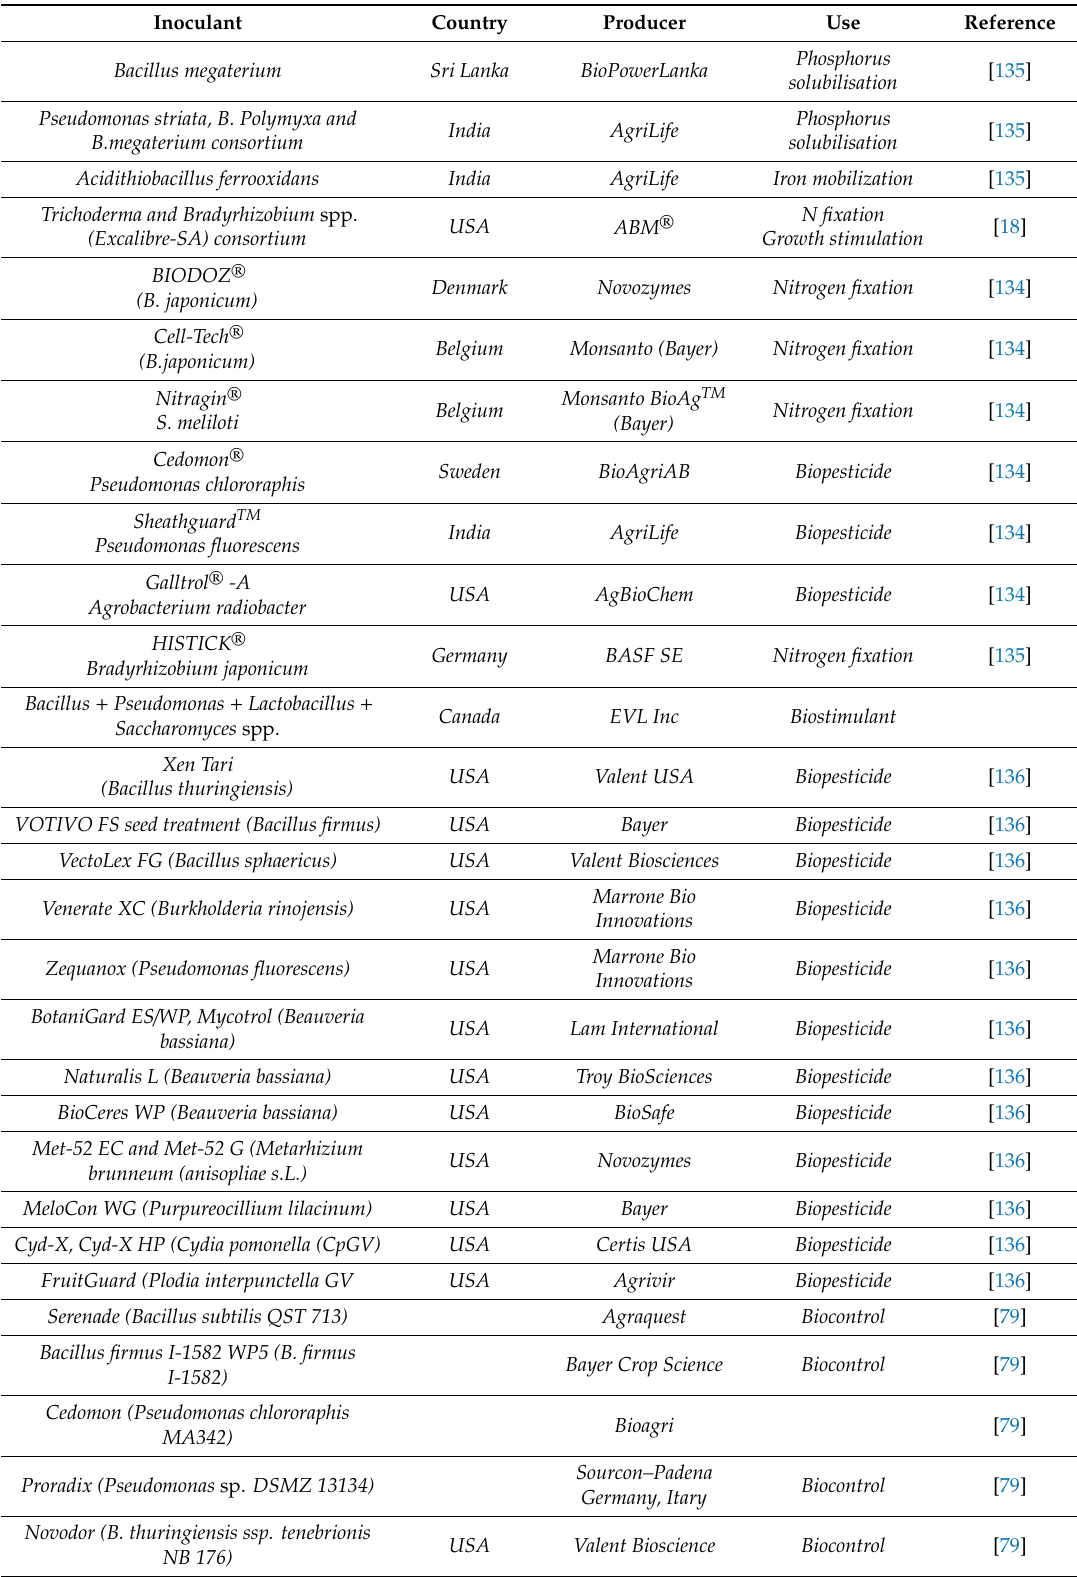
Table 3. Examplesofmicrobialinoculantscurrentlyavailableonthemarket,